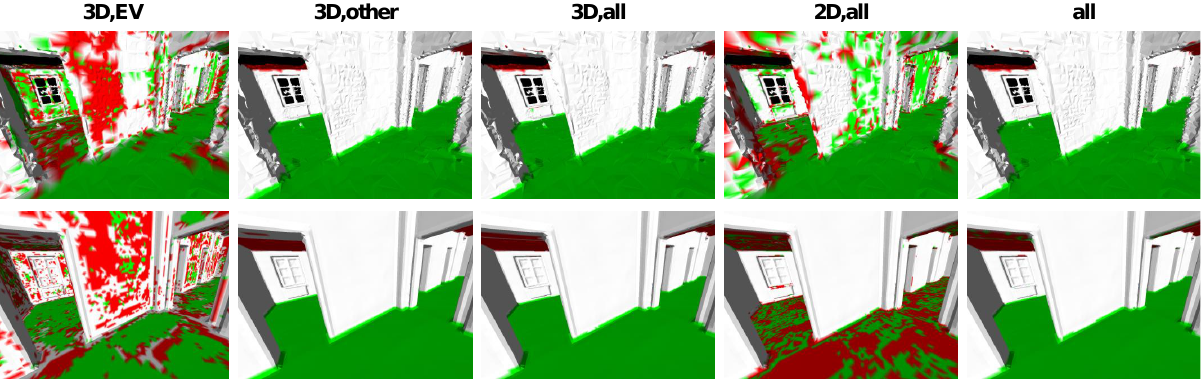
Figure 5. Classification results achieved using the set S 3D,EV including all eigenvalue-based 3D features, the set S 3D,other including all other geometric 3D features, the set S 3D,all including all 3D features, the set S 2D,all including all 2D features, and the set S all including all 3D and 2D features extracted from the HoloLens dataset (top row) and from the downsampled TLS dataset (bottom row): the class “Ceiling” is indicated in red, the class “Floor” in green and the class “Wall” in